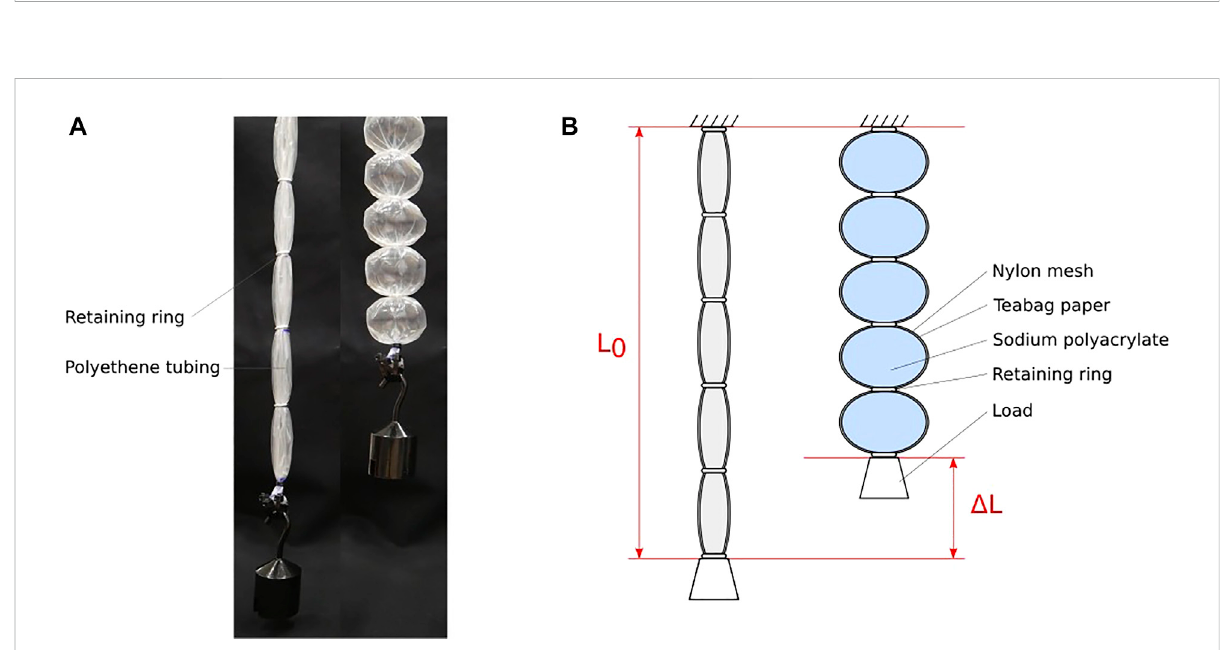
FIGURE 2 (A) PneumaticBAMactuatorrelaxed(left)andcontracted(right).ImagesreproducedwithpermissionfromDiteesawatetal.(2021) (B) SAP-BAM design. Left shows the actuator in salt water (relaxed), right shows the actuator in fresh water